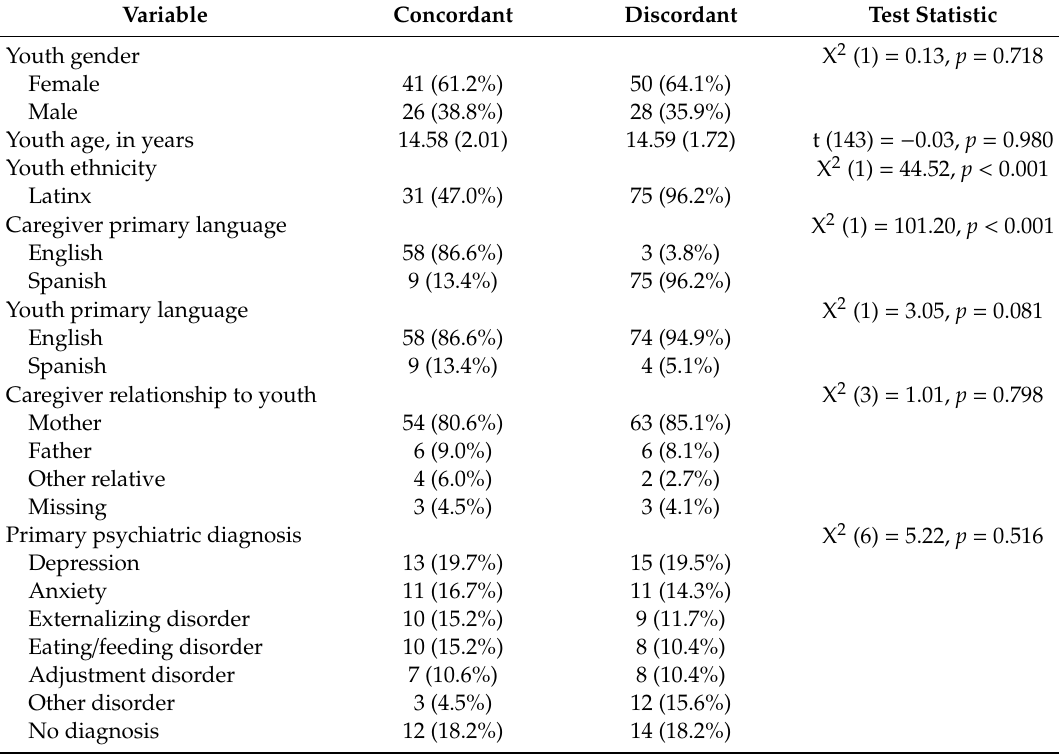
Table 1. Demographic statistics for the sample by youth–caregiver primary language